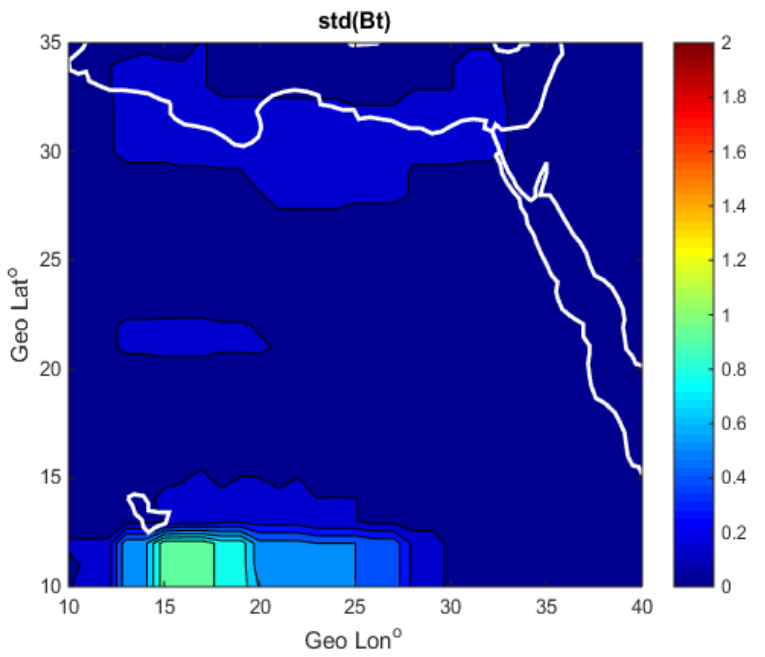
Figure 5. The standard deviation of the N–S gradient ∇ B t field component binned to regions of the surface area of 2.5 degrees.